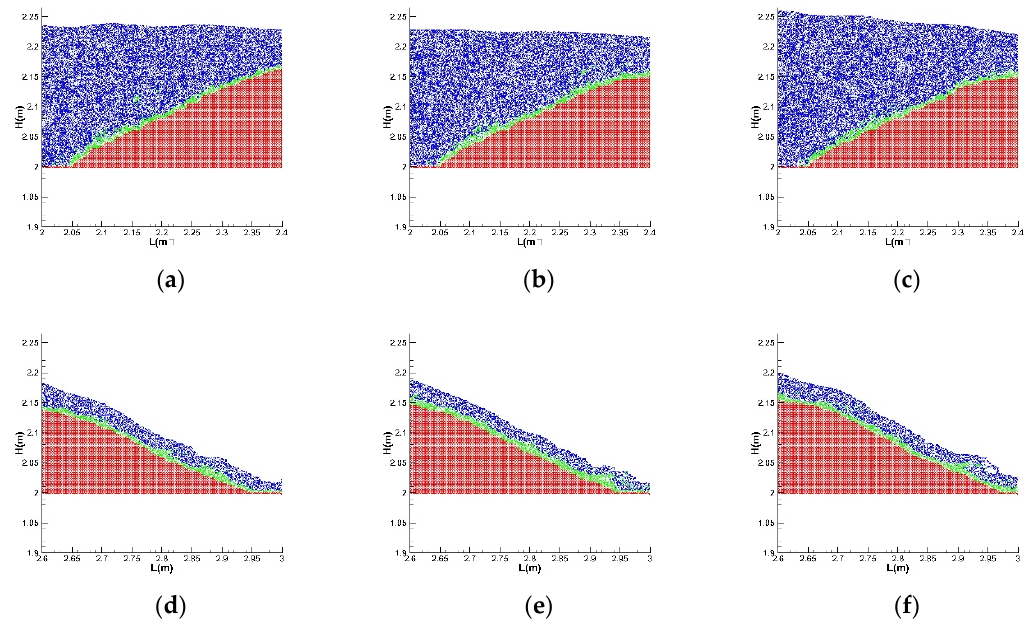
Figure 7. Debris flow free surface for tests 1, 2, 3 (Table 1), ( a ), ( b ) and ( c ) refer to the section upstream the dam body; ( d ), ( e ), and ( f ) refer to the section downstream the dam body. Table 1. Experimental conditions (viscosity values and interfacial force model) adopted for this study. Test